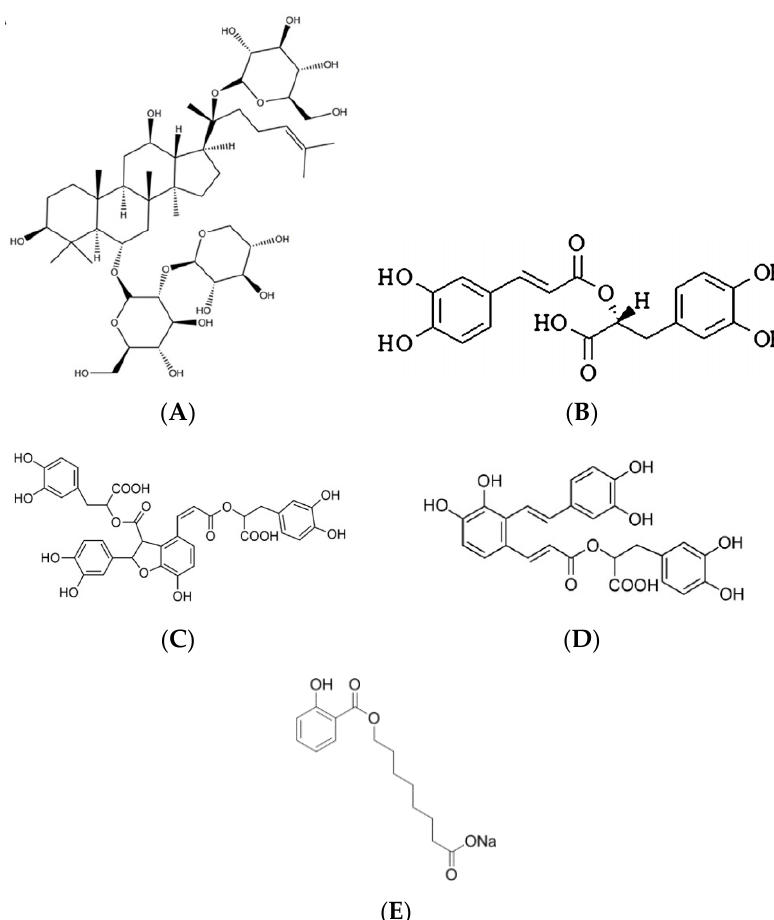
Figure 1. The chemical structures of sodium N -[8-(2-hydroxybenzoyl)amino]caprylate (SNAC) and drugs. ( A ) notoginsenoside R1. ( B ) rosmarinic acid. ( C ) salvianolic acid B. ( D ) salvianolic acid A. ( E ) SNAC.